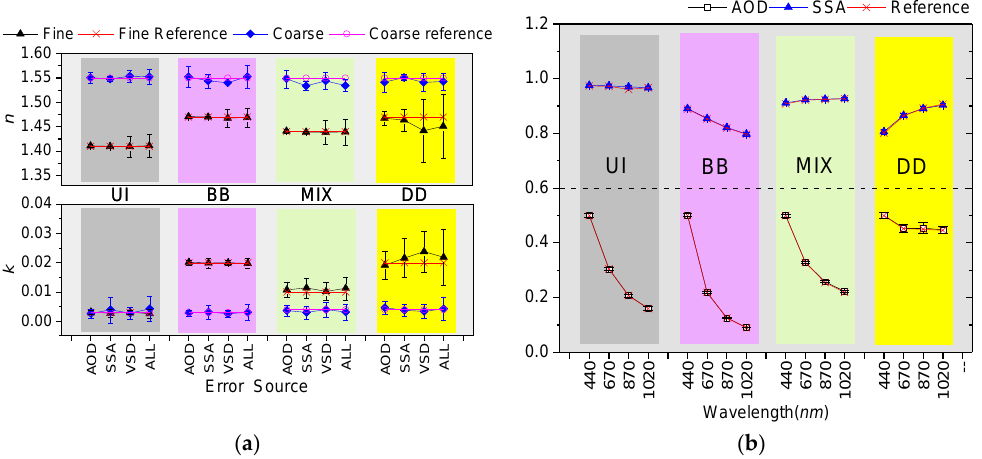
Figure 4. Comparison of ( a ) estimated and model aerosol refractive indices under different error conditions and ( b ) estimated and rebuilt AOD and SSA under synergetic errors in AOD, SSA, and VSD data.